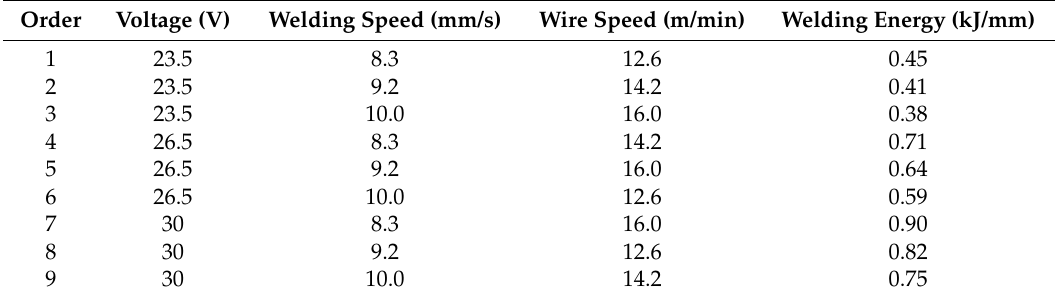
Table 3. Experimental array with the order of assays and their